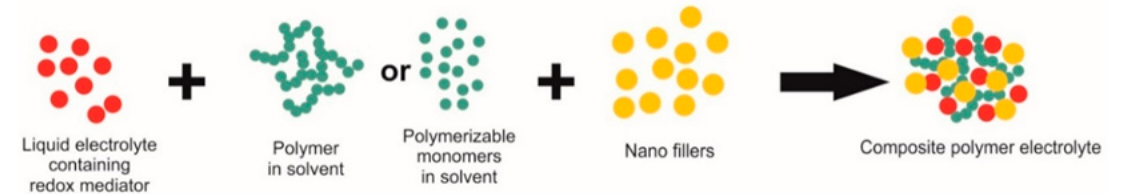
Figure 12. Schematic illustrations of composite polymer electrolyte preparation [261].